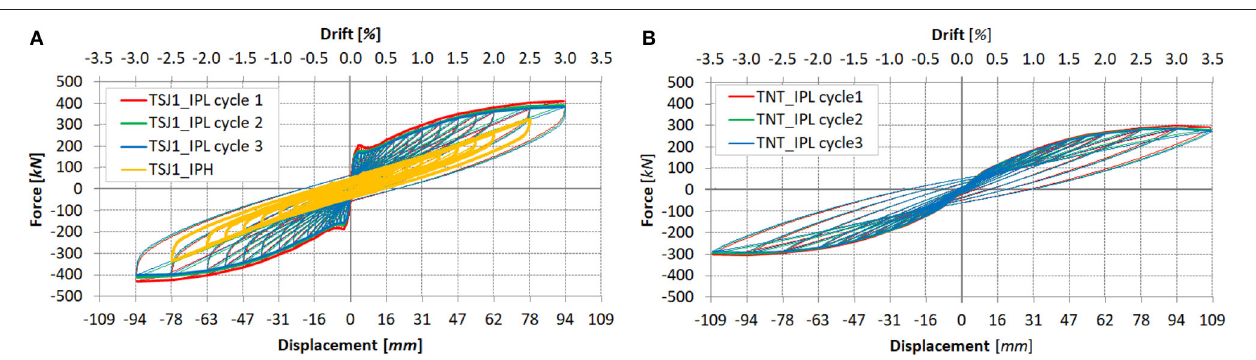
FIGURE 8 | Force–displacement curves on (A) TSJ1 and (B)